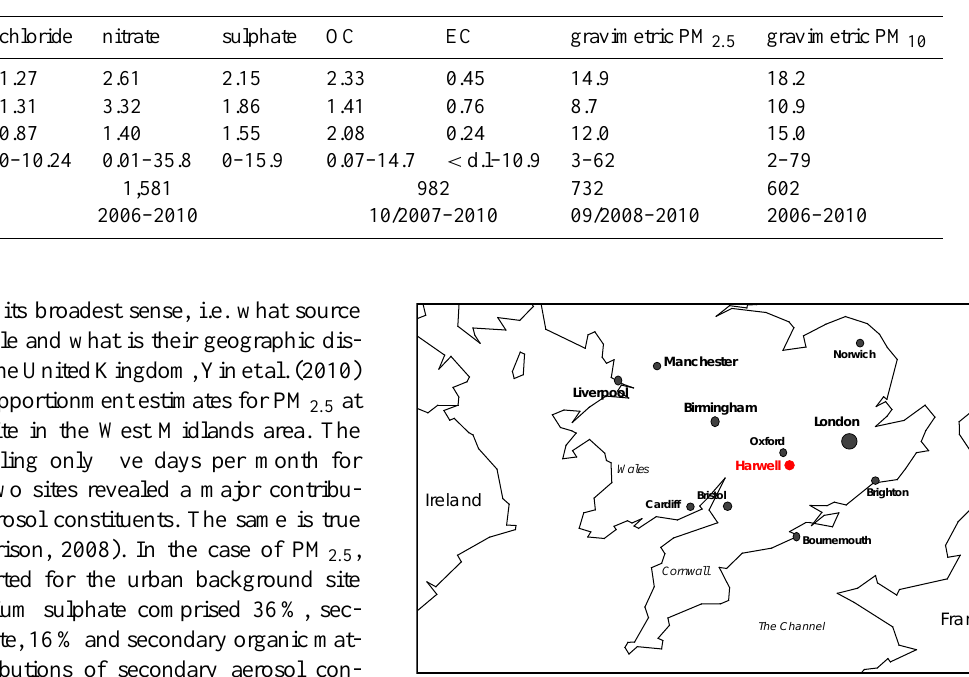
Table 1. Statistics of PM components and metrics measured at Harwell between 2006 and 2010 and included in the calculations. Concentra- tions in µgm − 3 .